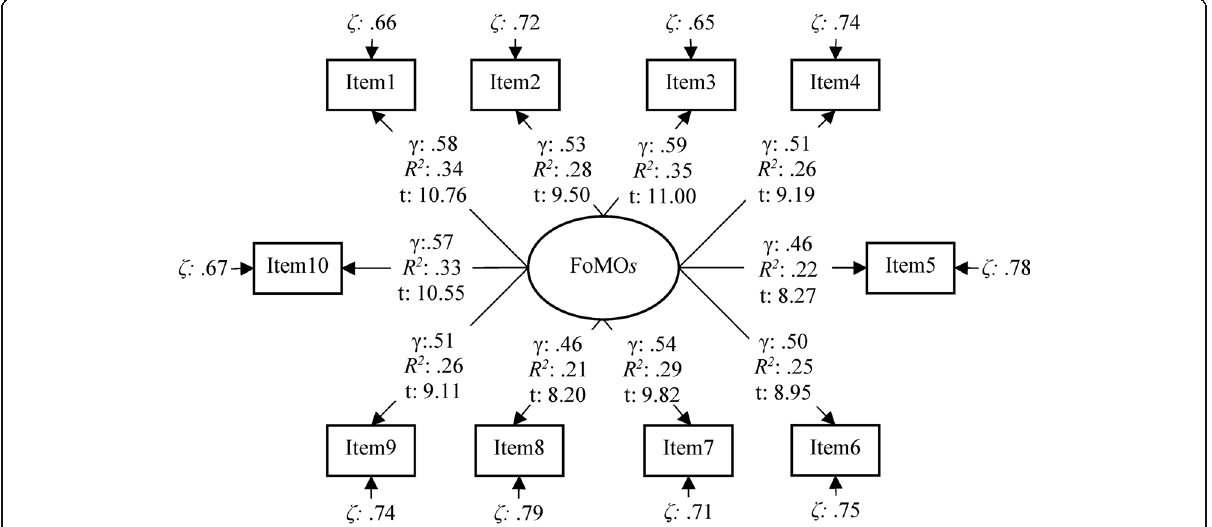
Fig. 1 The standardized loadings, standard errors, t , and R 2 values of the FoMOs. N = 354, γ = standardized loadings, ζ = error